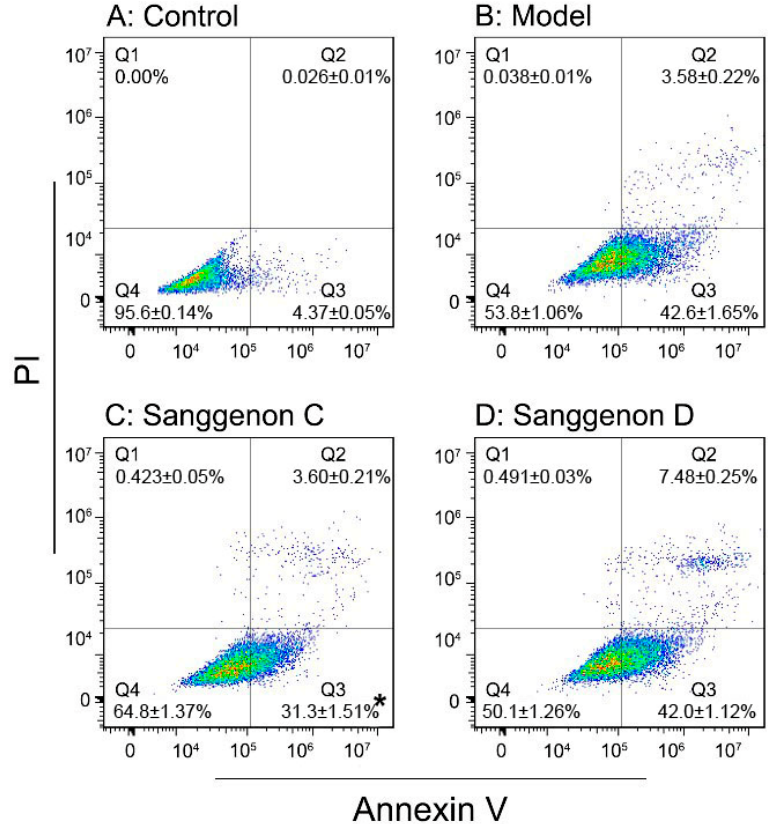
Figure 3. Cytoprotective effect of sanggenons C and D towards MSCs under oxidative stress based on flow cytometry assay (left upper, control; right upper, model; left lower, sanggenon C; right lower, sanggenon D). (MSCs, bone marrow-derived mesenchymal stem cells; each value is expressed as the mean ± SD, n = 3; * p < 0.05 vs. model.).